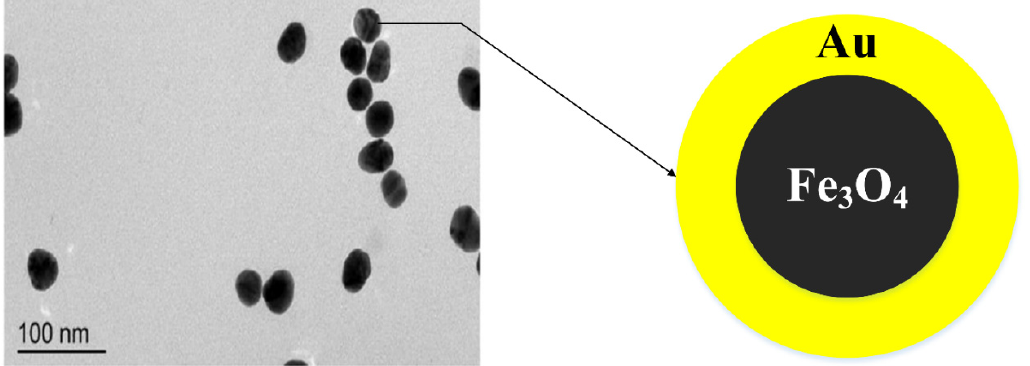
Figure 1. TEM image [20] and schematic diagram of Fe 3 O 4 @Au NPs core@shell construction.